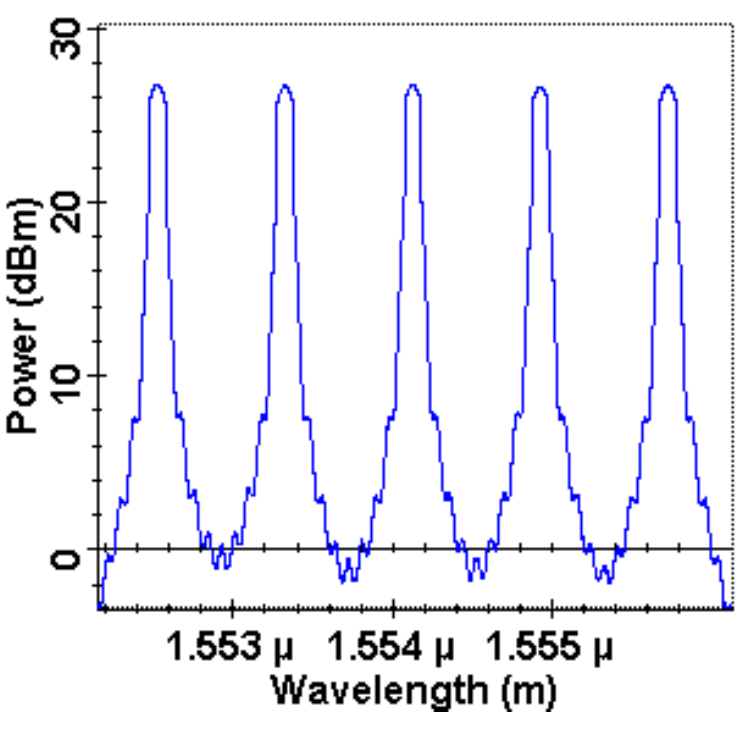
Figure 7. Representation of OCSs of different wavelengths.